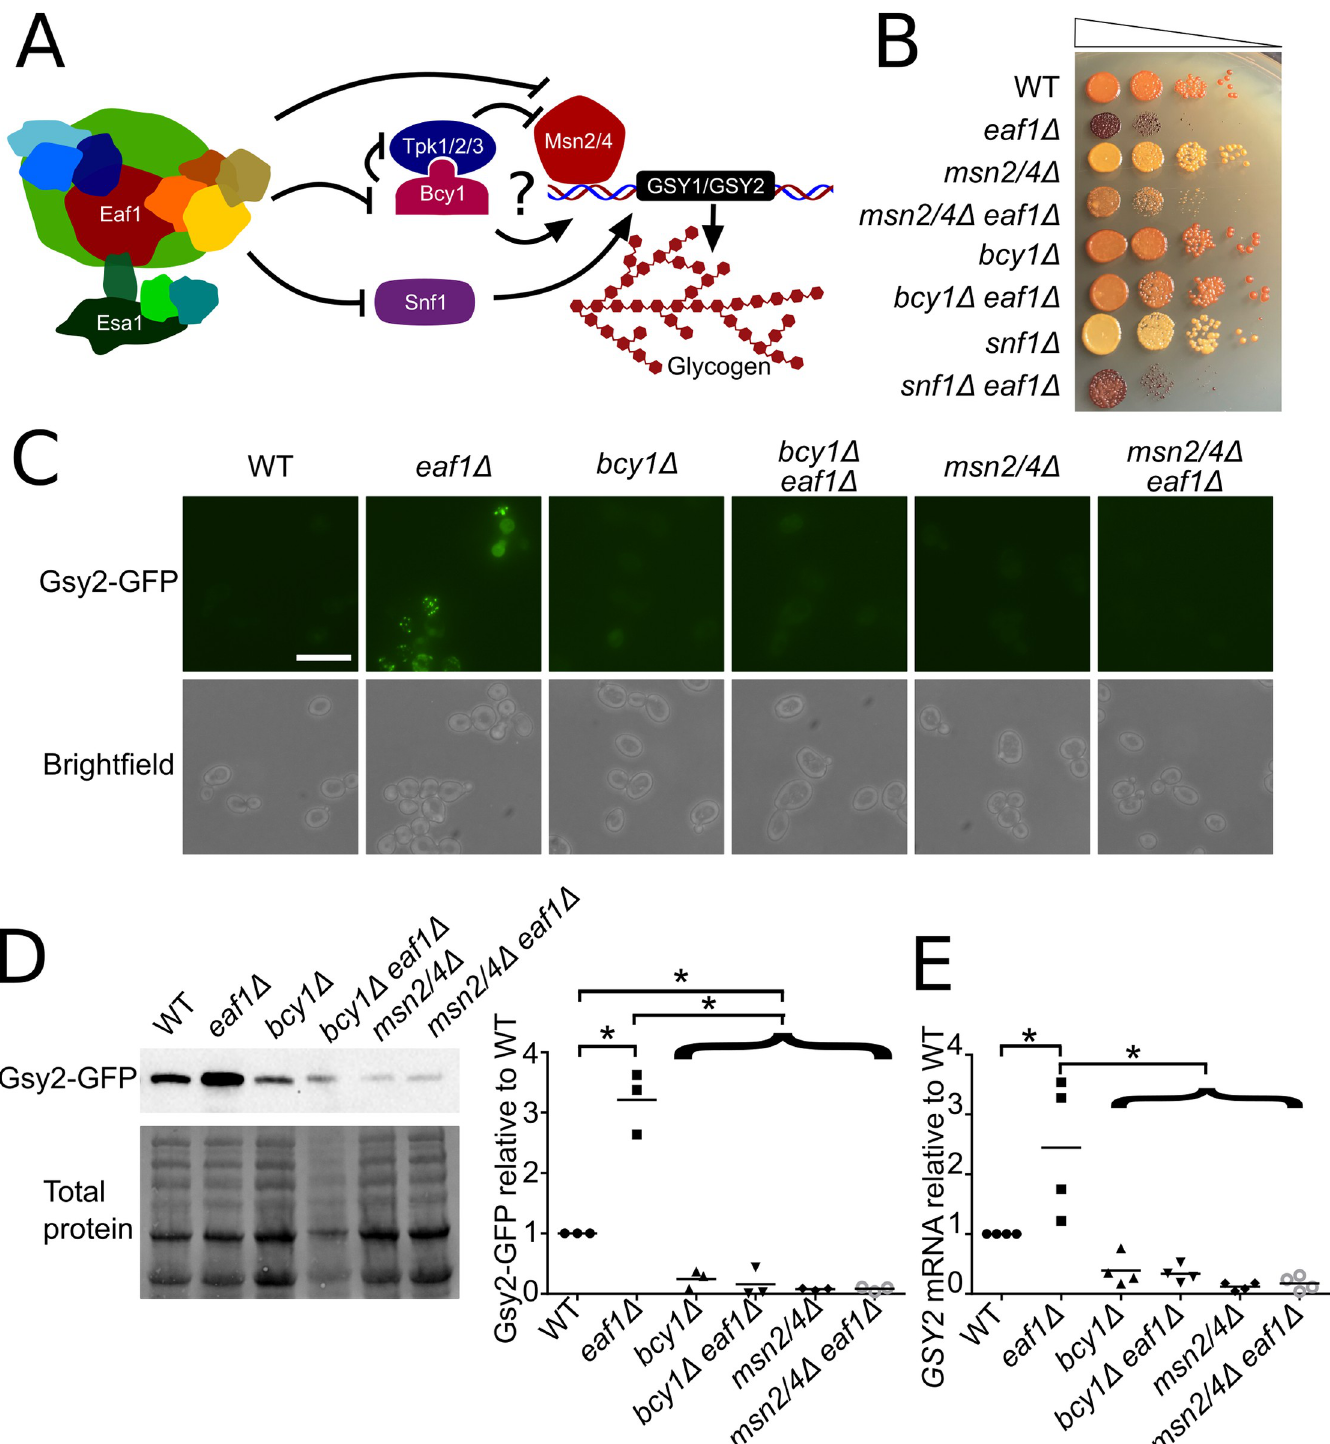
Fig 2. NuA4 regulation of glycogen biosynthesis proteins is mediated by PKA-Msn2/4 pathway. (A) Schematic model of NuA4 regulation of glycogen biosynthesis genes. (B) Increased glycogen levels in eaf1 Δ cells is suppressed by bcy1 Δ and msn2 Δ msn4 Δ . The indicated strains were serially diluted on to YPD plates, grown at 30˚C for 24 hours prior to exposure to iodine crystal vapours. Darker color corresponds to more glycogen storage. (C) Gsy2-GFP expression and localization were assessed in the indicated strain backgrounds by microscopy. Images are representative of three independent biological replicates. Scale bar = 10 μ m. (D) Gsy2-GFP protein levels were assessed by quantitative western blot analysis using whole cell extracts from the indicated strains expressing Gsy2-GFP. Panel to the left is representative anti-GFP